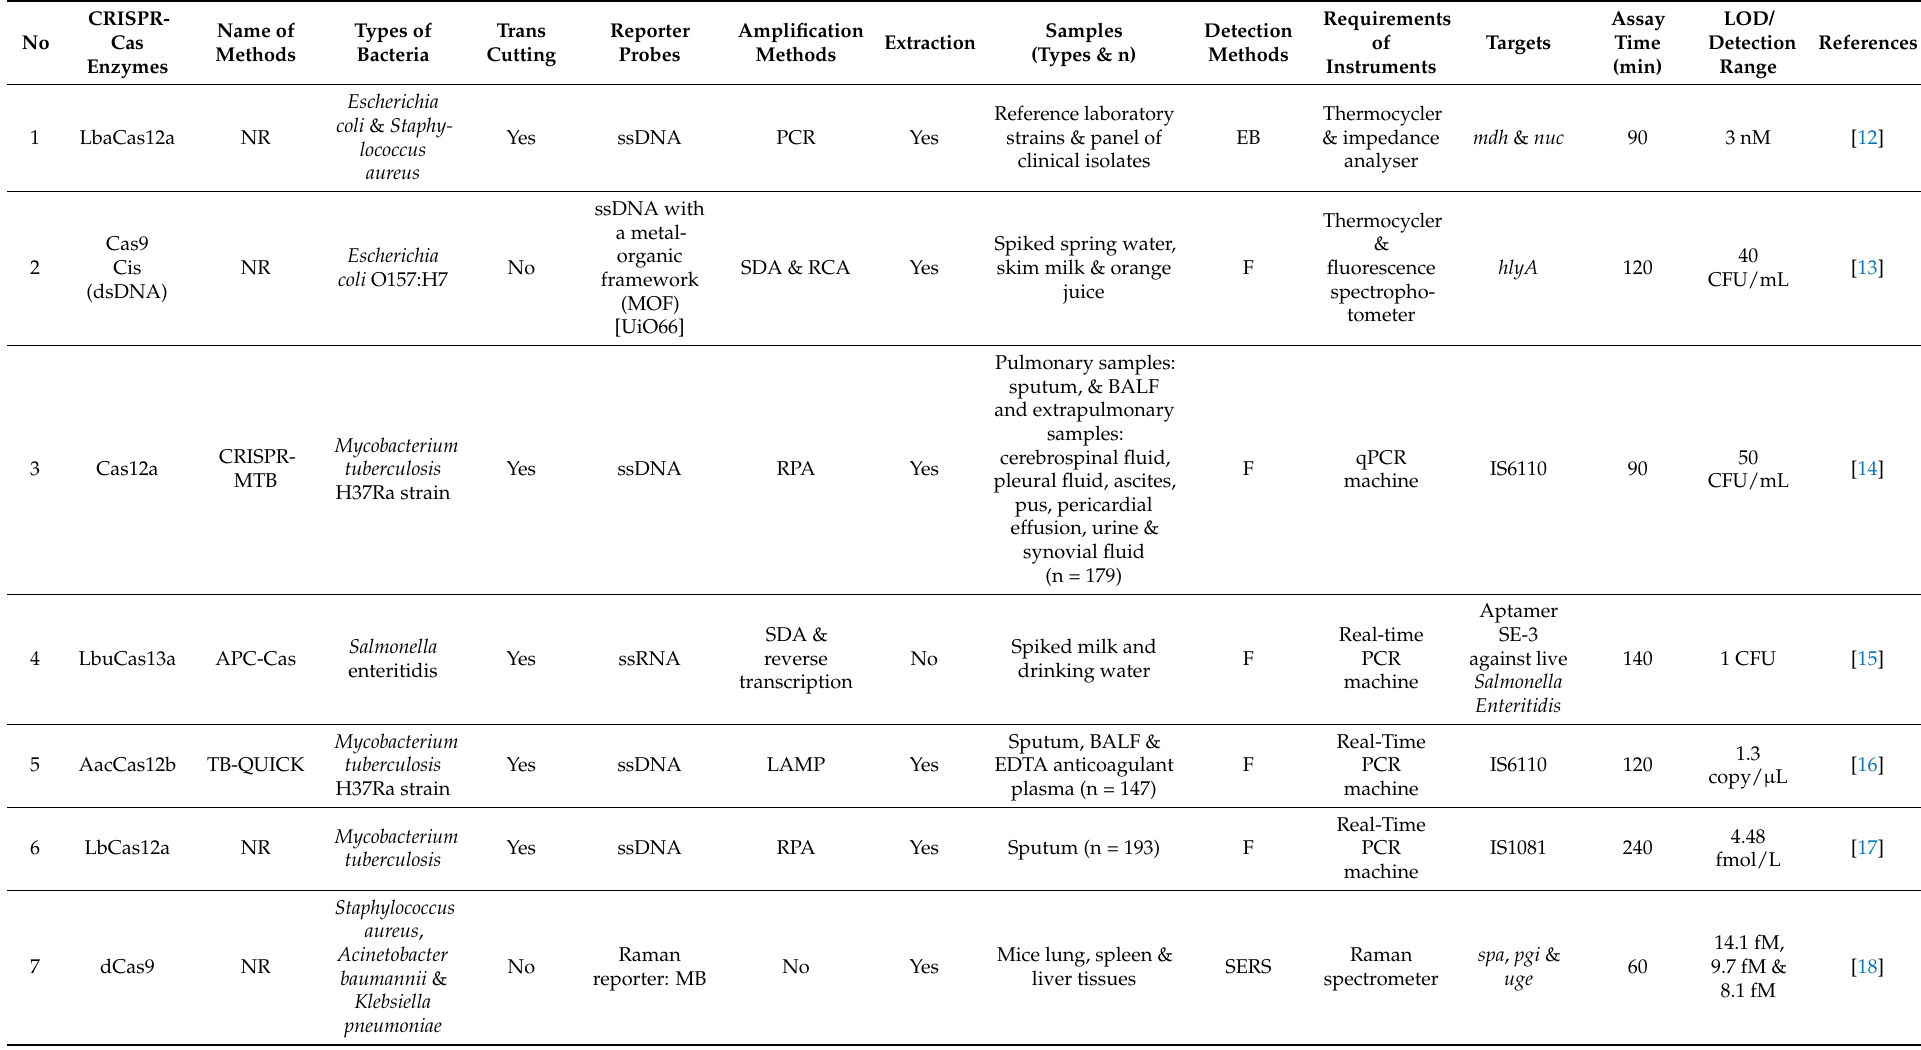
Table 1. Summary of the included